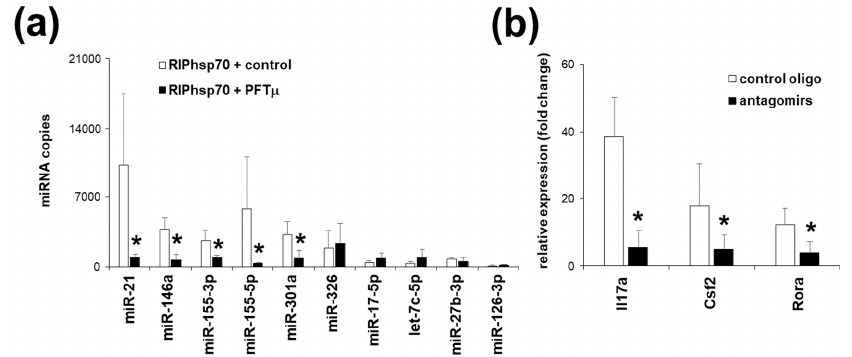
Figure 5. Th17-related subset of miRNA associates with HSP70. ( a ) Quantification of the miRNA copies in the anti-CD3-stimulated EL4 TCR + anti-HSP70 precipitate. ( b ) Gene expression analysis of the EL4 TCR + cells under anti-CD3 stimulation when co-transfected with miR-21, miR-146a, miR-155-3p, miR-155-5p and miR-301a antagomirs or with a control oligonucleotide. Data represent mean +/- SD. * p < 0.05, Student’s t -test.